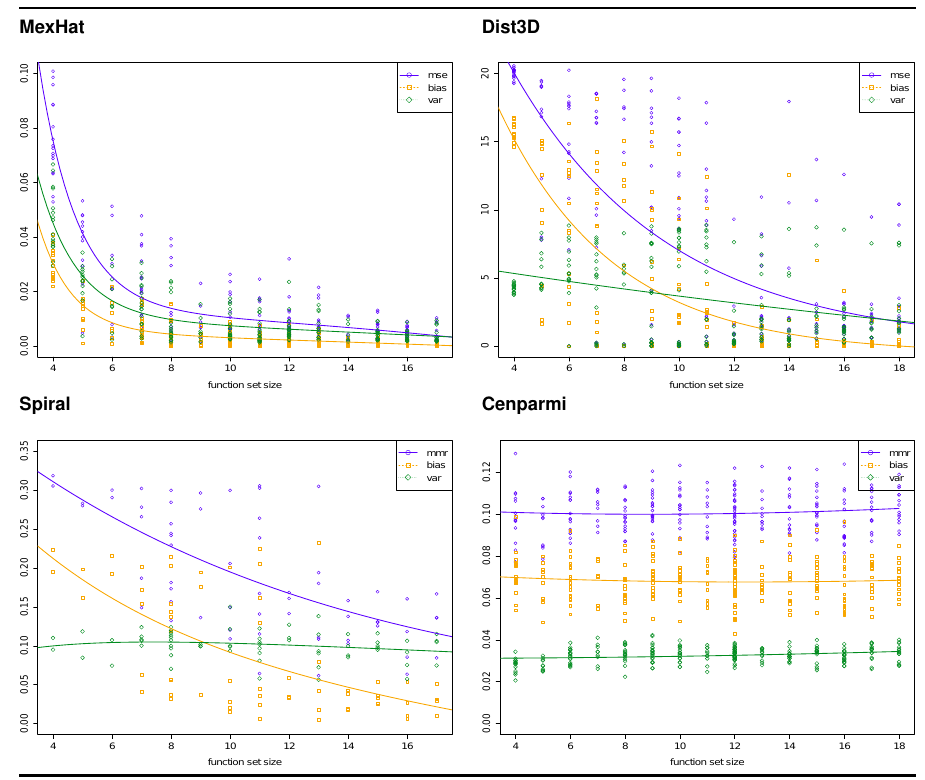
Fig. 7. Best-fit curves, varying over function set size j G j . Note the ill-fit curves for Spiral and Dist3D near the mid-range values, due to the arbitrary presence or absence of particularly useful